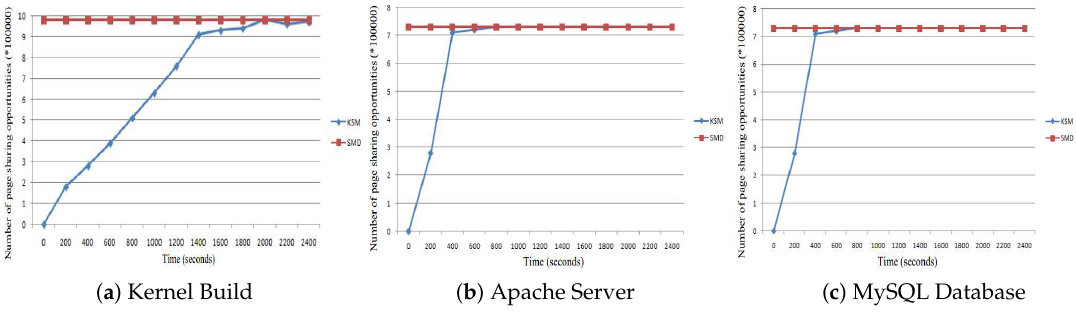
Figure 12. Page sharing opportunities with four VMs.